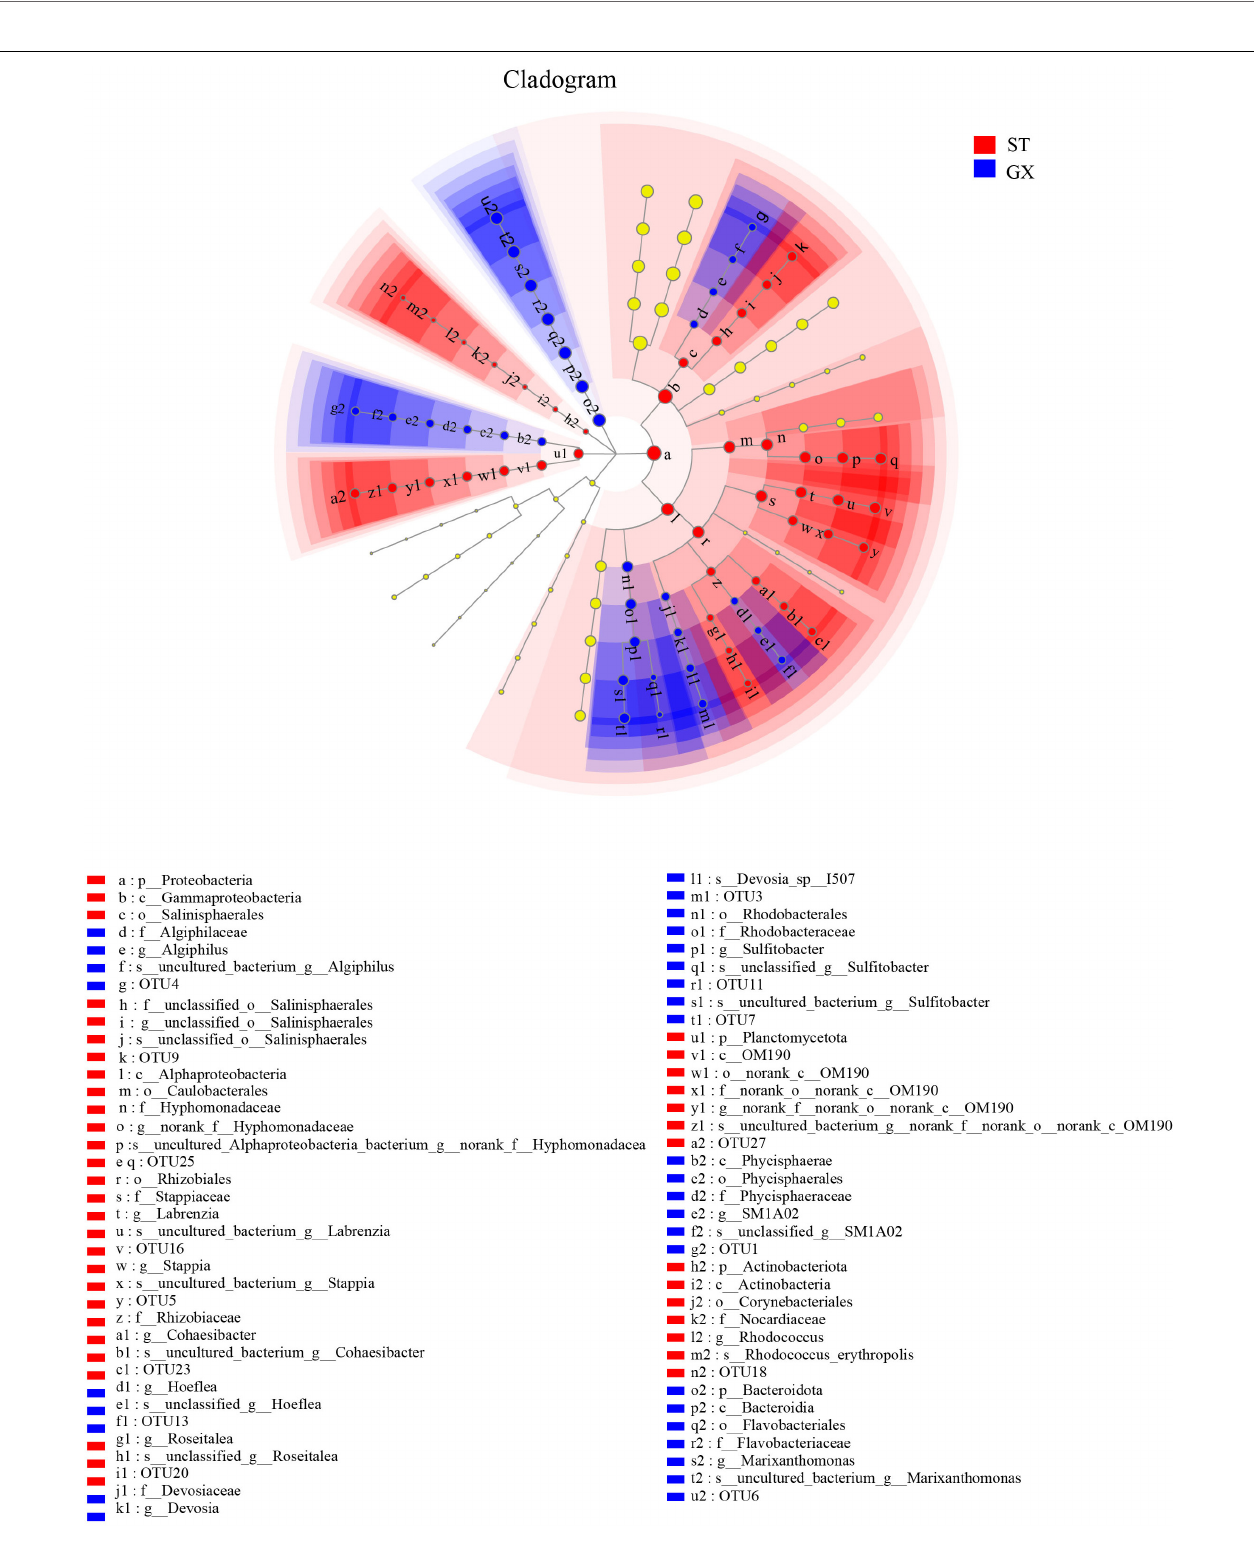
FIGURE 3 | Cladogram showing the phylogenetic distributions of bacterial taxa associated with Phaeocystis globosa cultures. Circles indicate the taxonomic level ranging from the phylum to OTU levels. The diameter of each circle is proportional to the abundance of that group. GX, P . globosa GX strain co-culture; ST, P . globosa ST strain co-culture. p, phylum; o, order; f, family; g, genus; s, species.